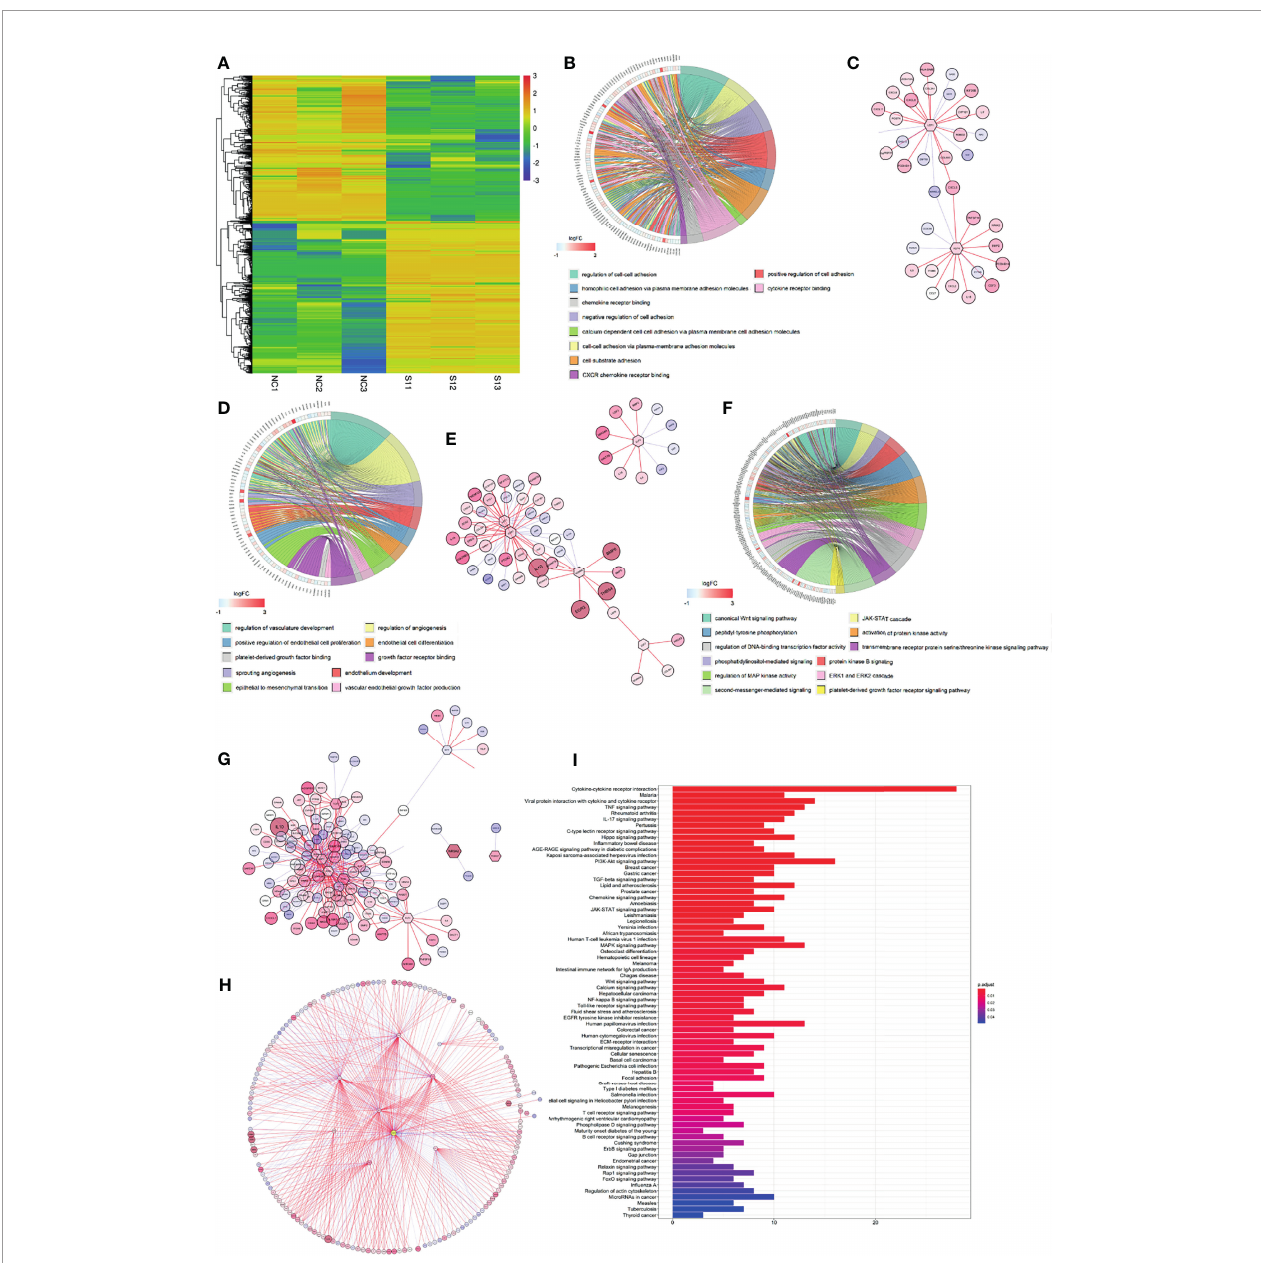
FIGURE 4 | CD248 promotes the role of CAFs in the TME. (A) Hierarchical clustering in the RNA-seq from the CD248 knockdown HFL-1 cell line. (B, D, F) Chord charts for the GO enrichment analysis. The left semicircle represents the genes and the right semicircle represents the functions of these gene sets involved in regulation. (C, E, G) PPI networks for each of the gene sets. (H) The total PPI network. (I) KEGG pathways enrichment analysis. p < 0.05 was considered to be statistically signi fi